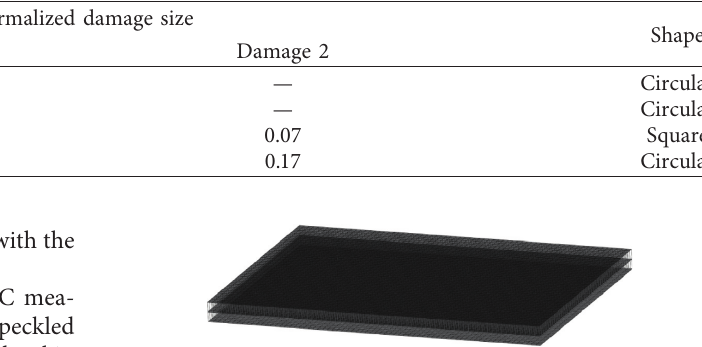
Figure 5: Numerical model representing the sandwich